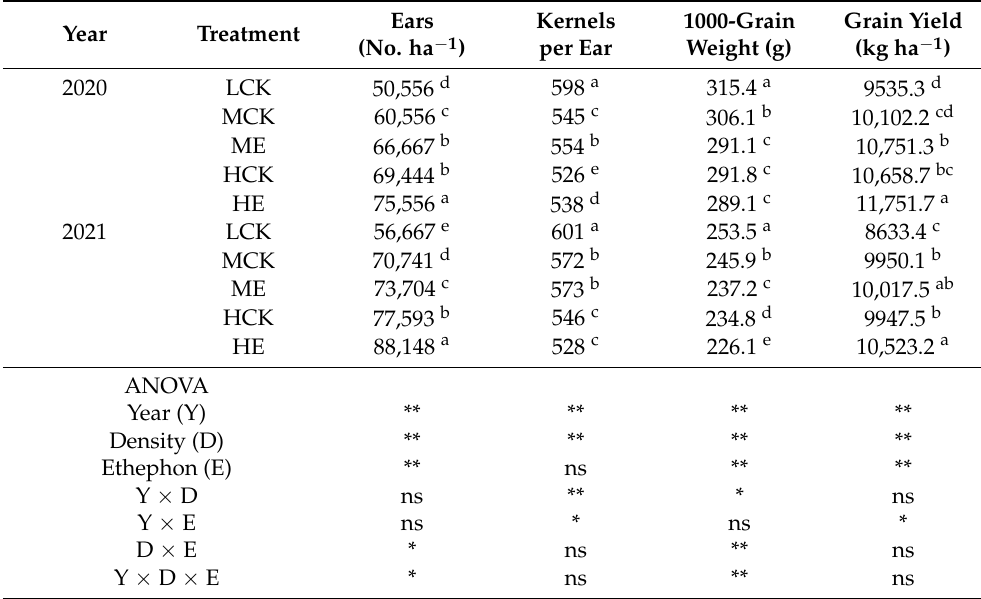
Table 5. Effects of spraying ethephon on grain yield and yield components of summer maize. Year Treatment